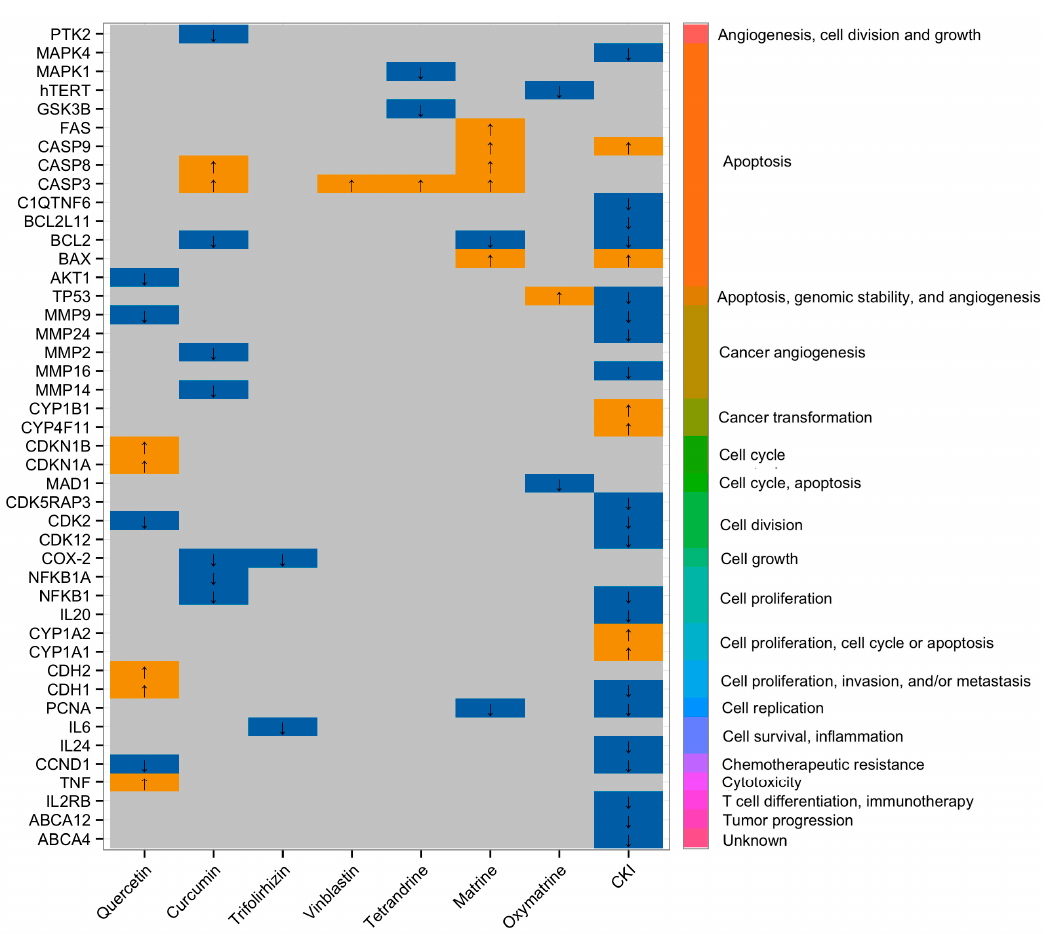
Figure 1. Differential gene expression in different cancer cell lines induced by flavonoids and alkaloids as well as Compound Kushen Injection (CKI). Left hand axis shows differentially expressed genes, bottom axis shows natural anti-cancer agent treatments (Quercetin, Curcumin, Trifolirhizin = flavonoids), (Vinblastine, Tetrandrine, Matrine, Oxymatrine = alkaloids), and (compound mixture = CKI) and the right hand axis shows Gene Ontology (GO) clustering and annotation of differentially expressed genes. Up and down-regulated genes (up = YELLOW and down = BLUE) known to be affected by natural compound anti-cancer agents were obtained from http://crdd.osdd.net/raghava/npact/browse.php and significantly differentially expressed genes from CKI treated MCF-7 cells were obtained from RNA-Seq experiments conducted by Qu et al. [87]. Table 1. Reported therapeutic effects by single or mixtures of natural compounds in different stages of cellular mechanisms.